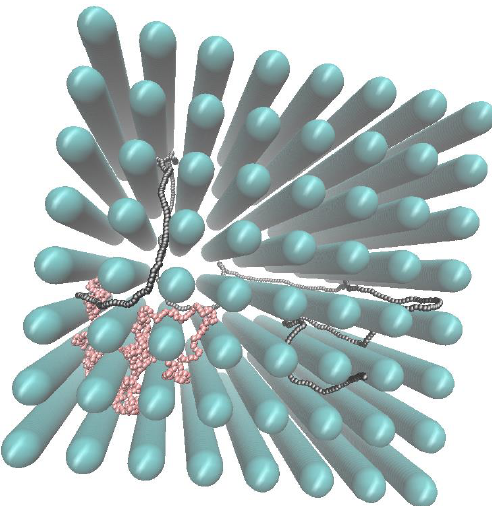
Figure 2. Snapshot of a diblock copolymer composed of the flexible and semi-flexible block in an array of nanoposts with the size d p = 6.9 and spacing S p = 12. The pink and gray beads belong to the flexible and semi-flexible block, respectively.